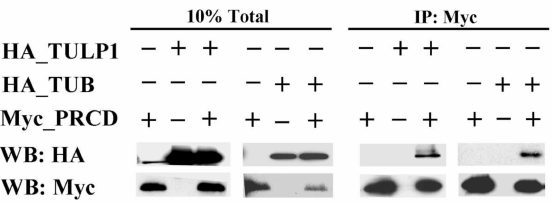
Figure 2. Verification of the interaction between PRCD, TULP1, and TUB by co-immunoprecipitation (co-IP). COS-7 cells were transiently co-transfected with di ff erent combinations of PRCD_Myc, TULP1_HA, and TUB_HA. Cell lysates were subjected to co-IP with an anti-Myc tag antibody, and eluted proteins as well as total cell lysates were separated by SDS-PAGE, followed by Western blotting (WB) with anti-HA and anti-Myc tag antibodies. The presence of TULP1 and TUB in the anti-Myc tag immunocomplexes supported their interaction with PRCD in mammalian cells.